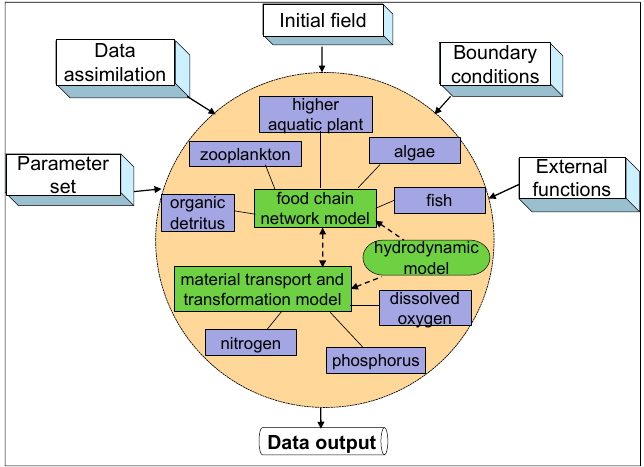
Figure 2. Components and structure of the EcoTaihu model (source: Zhang et al. [55]).